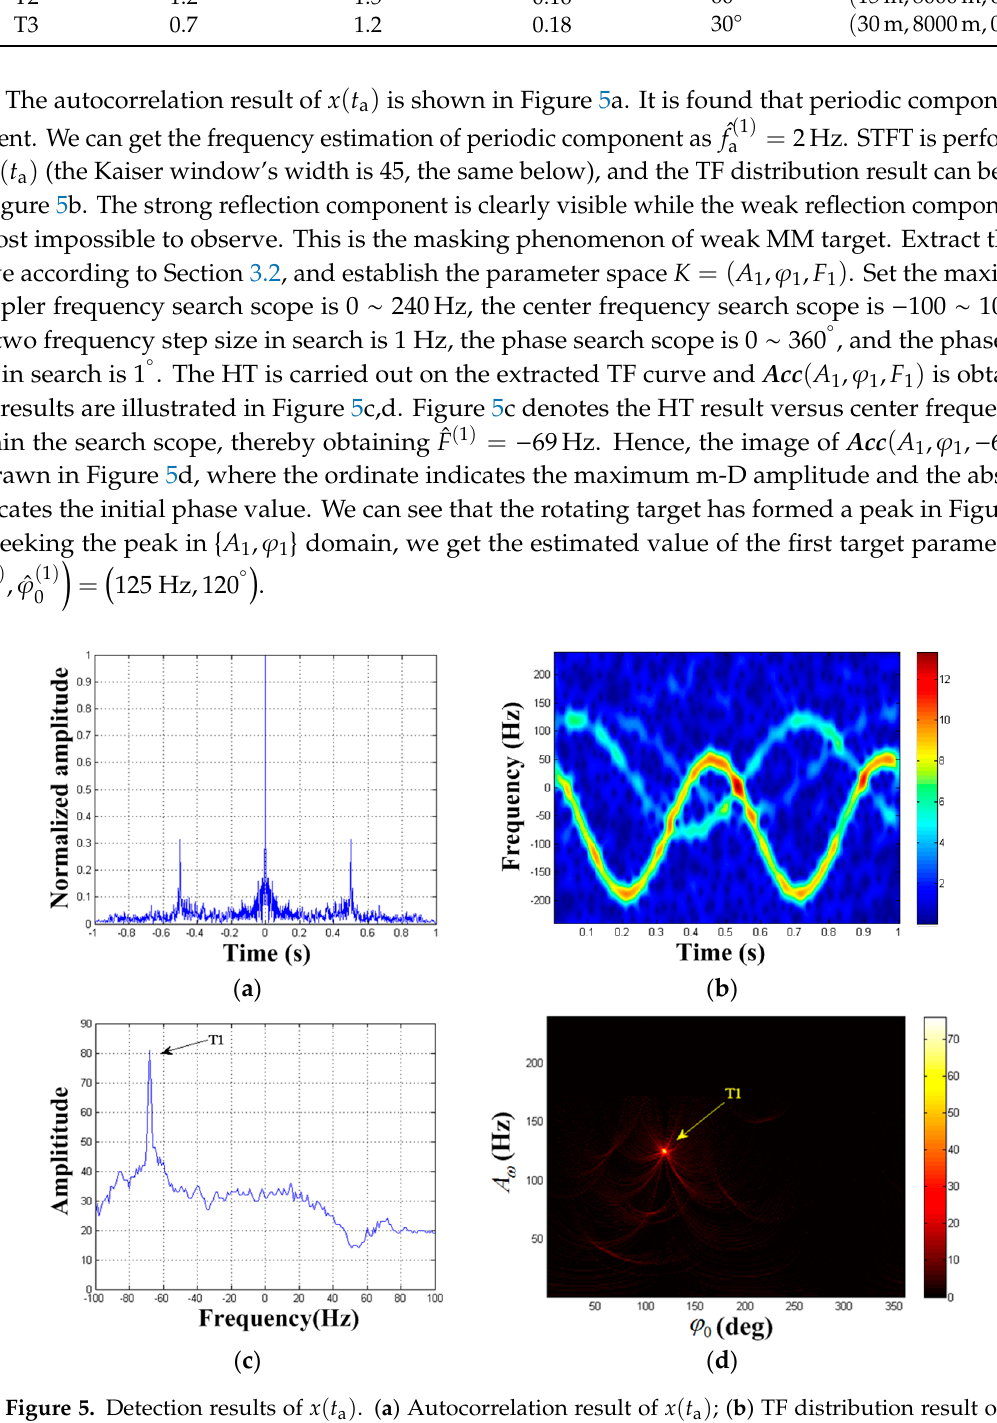
Figure 5. Detection results of